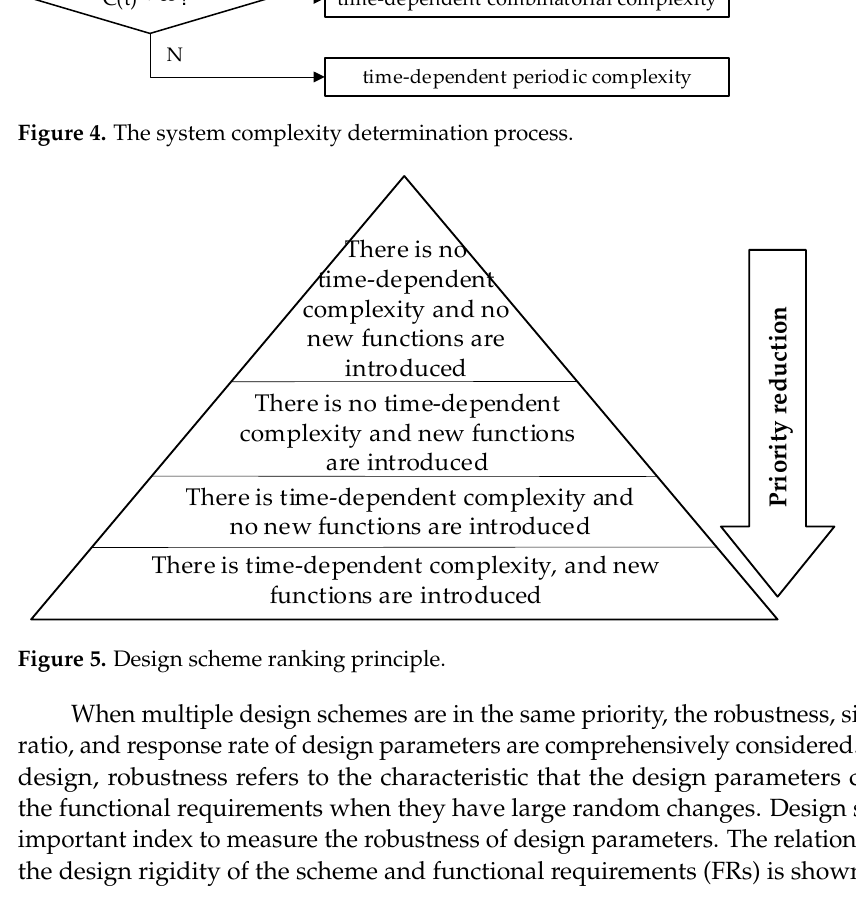
Figure 4. The system complexity determination process.